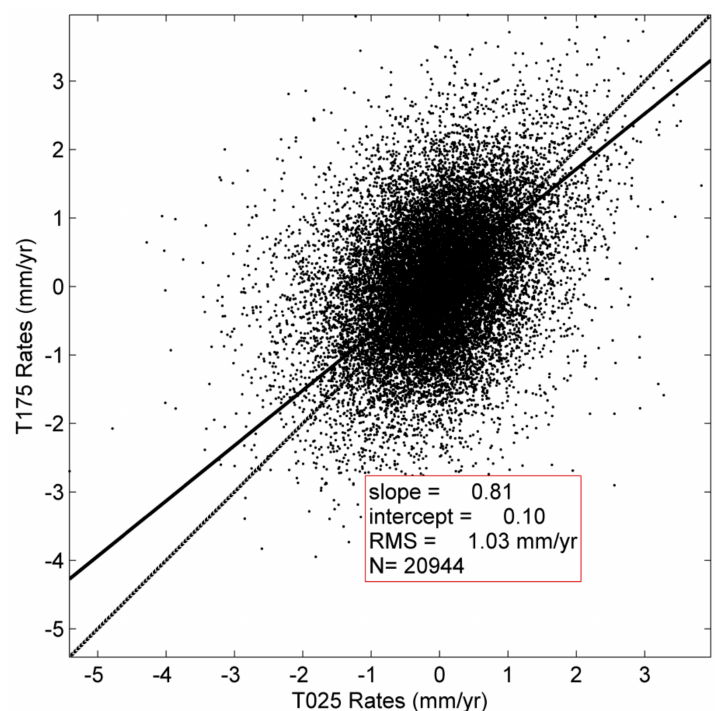
Figure 6. Vertical rates estimated from time series of ASAR T175 and T025. Scatter plot shows all pixels common to both tracks. Best-fit line is shown (solid line) along with the 1:1 line